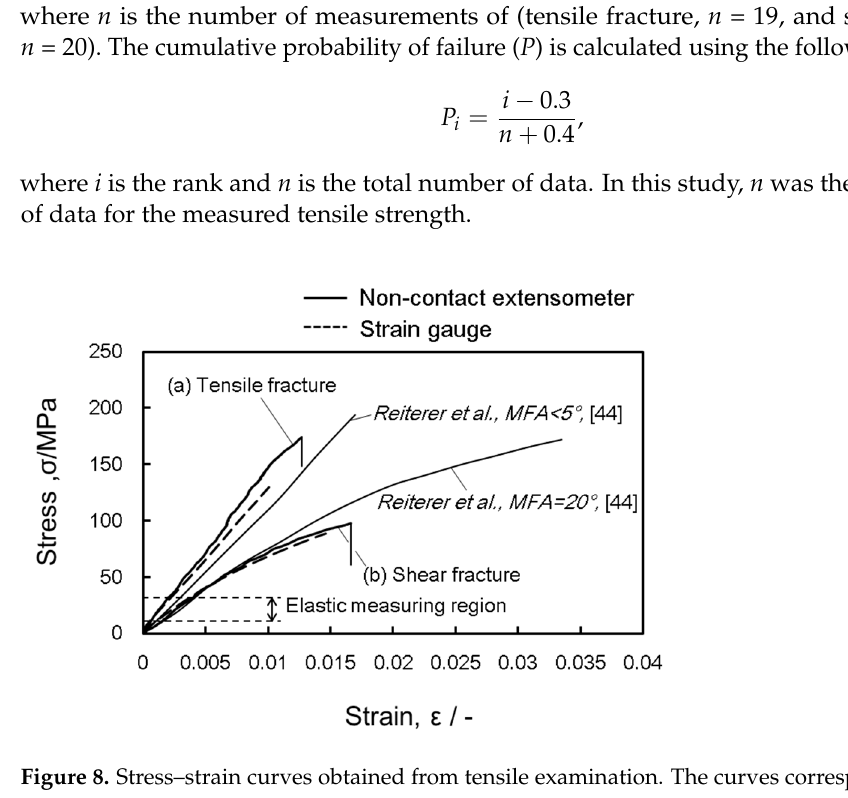
Figure 8. Stress–strain curves obtained from tensile examination. The curves correspond to the two respective failure modes.